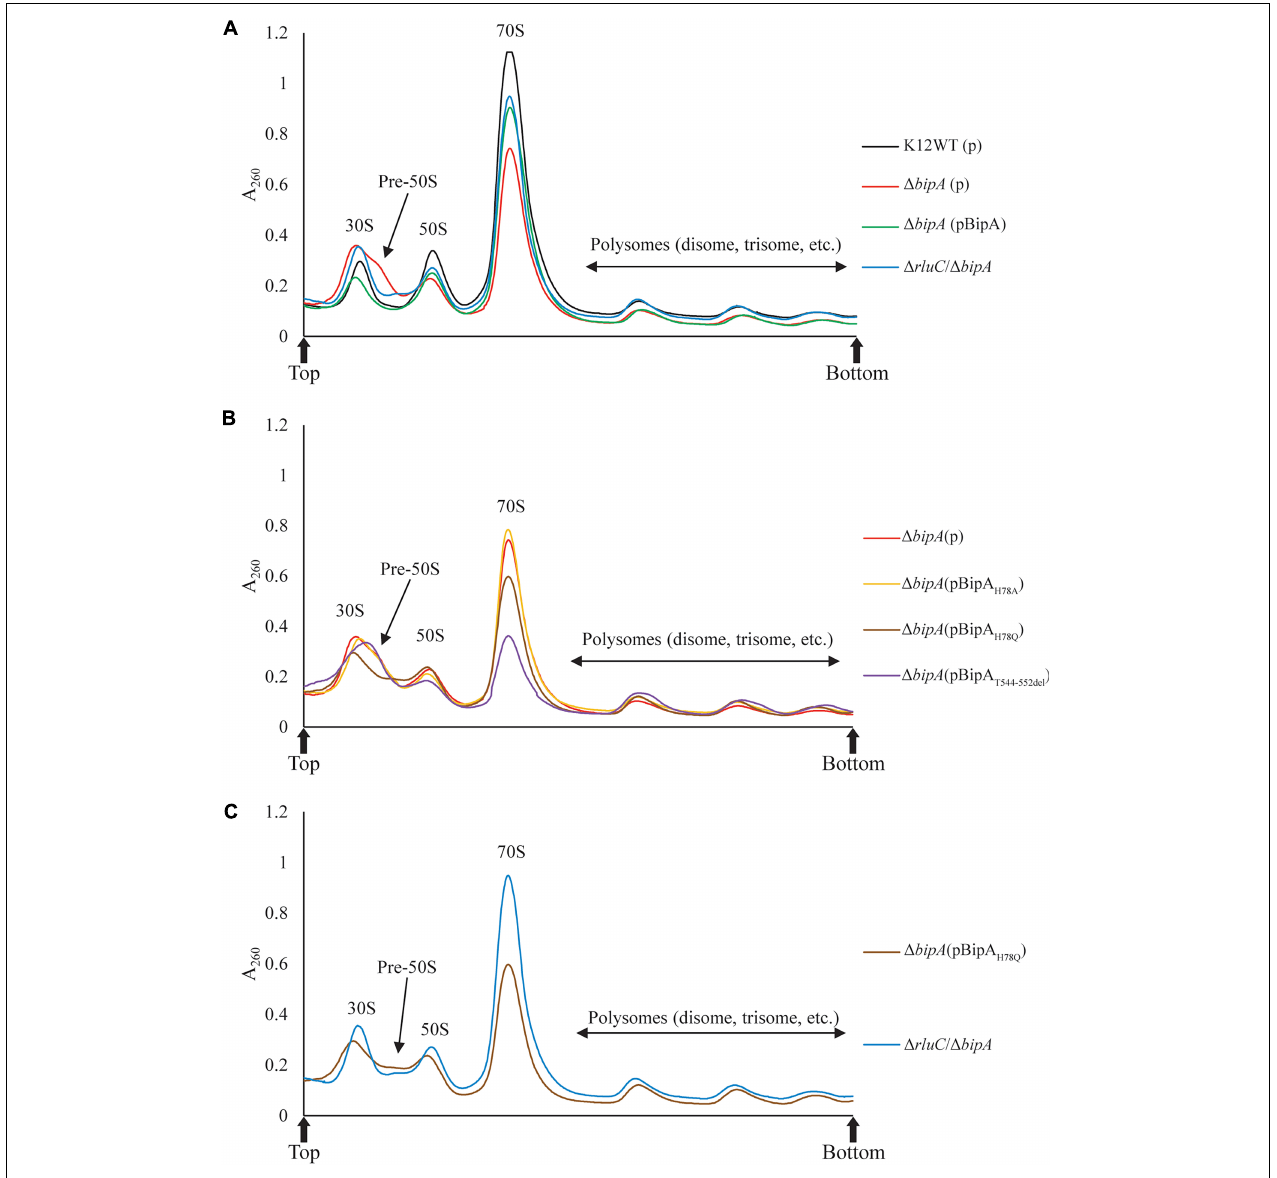
FIGURE 3 | Ribosomal particle distribution showing ribosome assembly defects caused by bipA deletion and BipA mutants. Peaks corresponding to polysomes, 70S ribosome, and free subunits are indicated. (A) Using K12WT (black) as a reference, (cid:49) bipA (red) presented accumulation of ribosomal subunits and reduction of 50S and 70S ribosomal particles, deduced from the higher 30S peak and lower 50S and 70S peaks, respectively. The pre-50S peak appeared as a minor peak between 30S and 50S peaks in (cid:49) bipA ribosomal particle distribution. Although with a lower 70S peak, the profile of (cid:49) bipA (pCA24N-BipA) (green) was similar to K12WT. The (cid:49) rluC / (cid:49) bipA (blue) yielded similar 50S and 70S peaks as K12WT, but similar 30S peak as (cid:49) bipA . Notably, the region between the peak of 30S and 50S subunits was slightly elevated indicating maturing pre-50S. (B) The (cid:49) bipA (pCA24N-BipA H78 A ) (yellow) yielded almost identical ribosomal particle distribution as (cid:49) bipA . While (cid:49) bipA (pCA24N-BipA H78 Q ) (brown) had lesser 70S ribosome, the pre-50S peak was not visible. The (cid:49) bipA (pCA24N-BipA T544_ D 552 d el ) (purple) produced the least 70S and 50S particles with a skewed 30S peak, which may include a large population of pre-50S particles. (C) A comparison between sucrose gradient profiles of the strains (cid:49) rluC / (cid:49) bipA and (cid:49) bipA (pCA24N-BipA H78 Q ). The data showed similarity in terms of reduced pre-50S with elevated area under the peak between 30S and 50S peaks, likely representing a population of pre-50S that had mature further than what was seen in (cid:49) bipA . The “p” in the bracket alone or preceding “BipA” represents plasmid pCA24N. Peaks corresponding to subunits (30S, pre-50S, and 50S), monosomes (70S), and polysomes are indicated. Top and bottom of each gradient are marked with arrows.